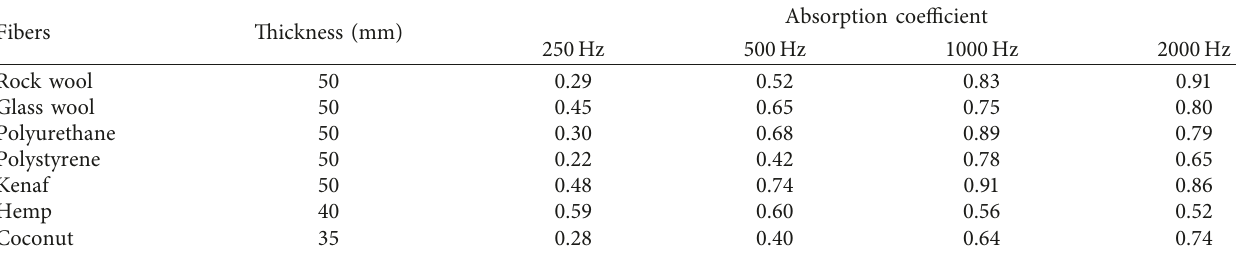
Table 9: Comparison of acoustic absorption coefficients between natural and synthetic fibers [70].